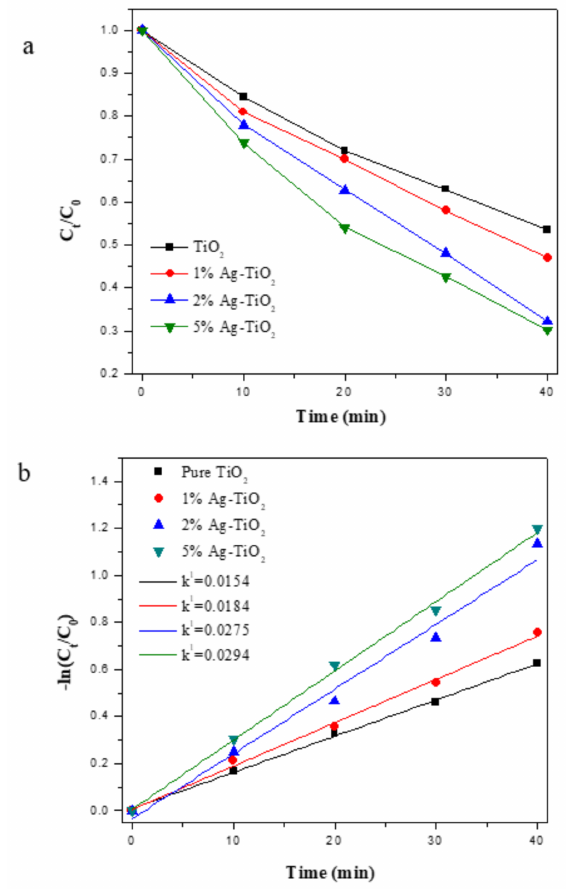
Figure 7. Degradation rate of MB ( a ) and photocatalytic reaction rate ( b ) of TiO 2 and Ag-TiO 2 samples under solar